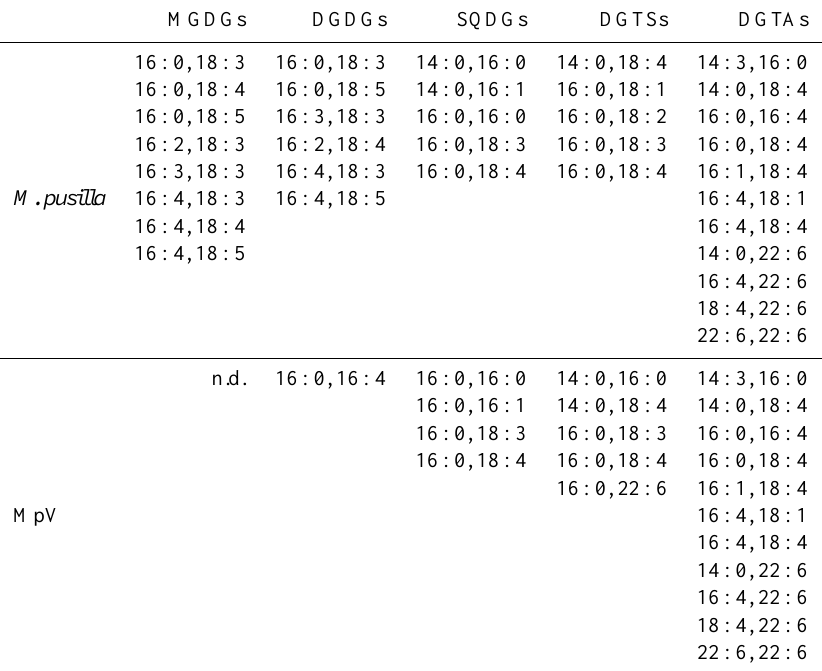
Table 3. Fatty acid combinations (chain length:double bonds) for the SQDGs, DGDGs, MGDGs, DGTSs and DGTAs of M. pusilla and its virus MpV. The fatty acid combinations of the PGs could not be determined with the diagnostic tool. n.d. stands for non-detected. MGDGs DGDGs SQDGs DGTSs